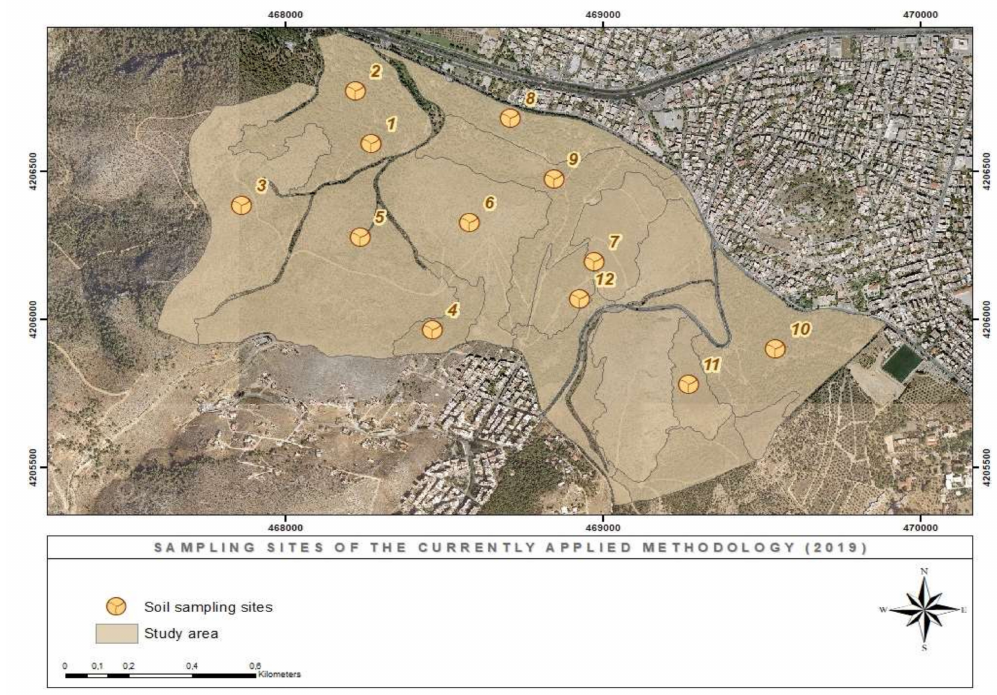
Figure 3. Soil sampling sites of the currently applied mapping method.